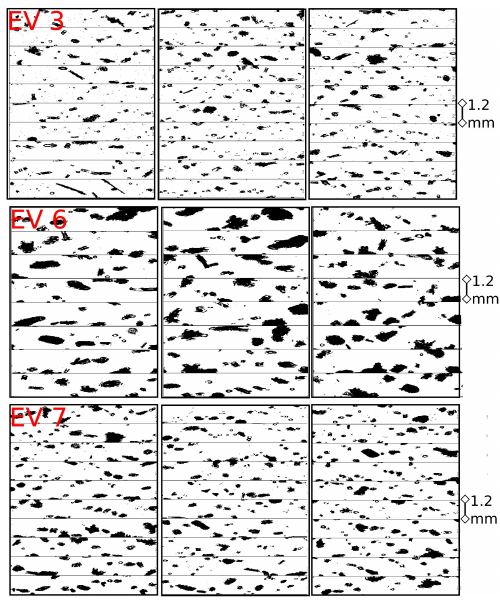
Figure 7. Particle images collected at the JFJ location by a 2D-S particle imager. Three cases are shown, corresponding to the po- larimetric observations of Fig. 6. Top panel: EV3, on 1 February 2014, around 23:00UTC. Middle panel: EV6 on 6 February 2014, around 10:00UTC. Bottom panel: EV7 on 8 February 2014, around